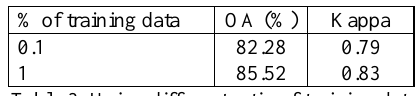
Table 2. Using different number of dates